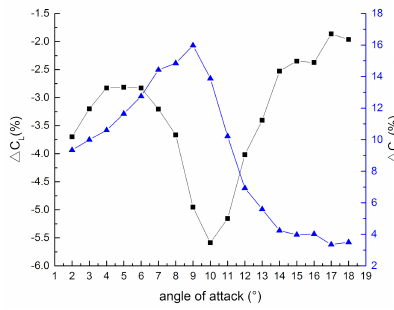
Figure 15. Lift and drag coefficient increments of NH6MW25 at m = 1% and Re = 1 × 10 6 .